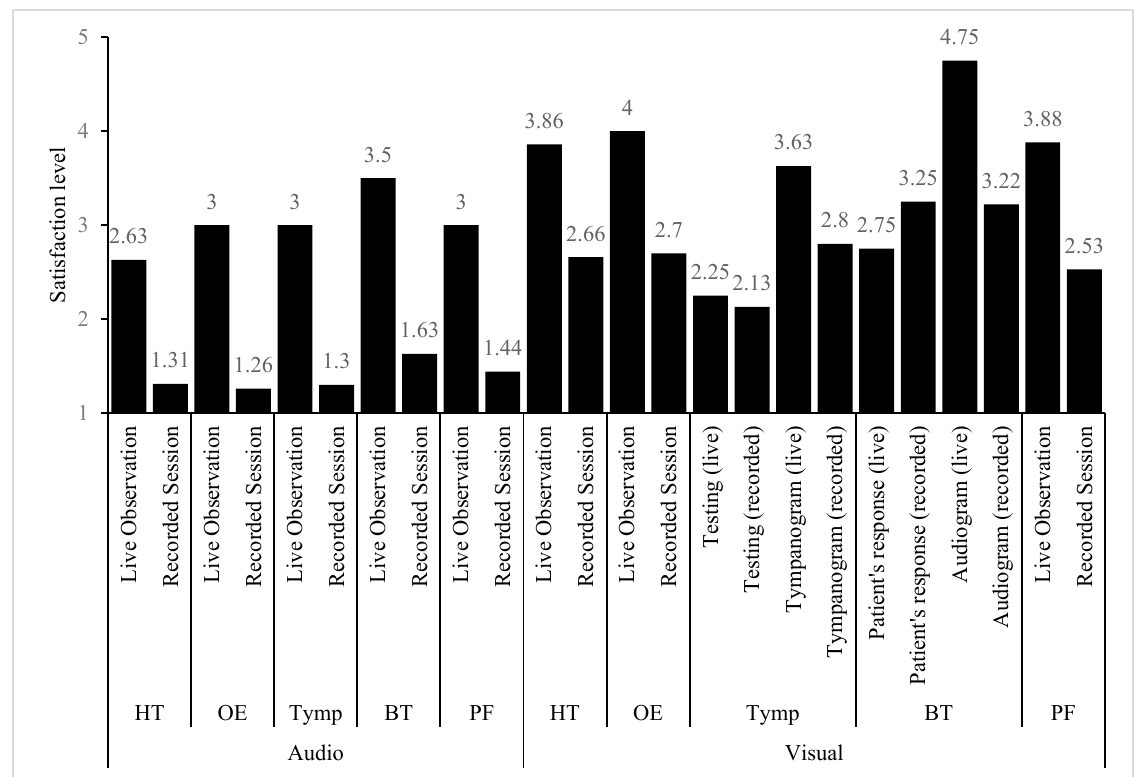
Figure A2. Mean values for Internet speed measurements using three different laptops.